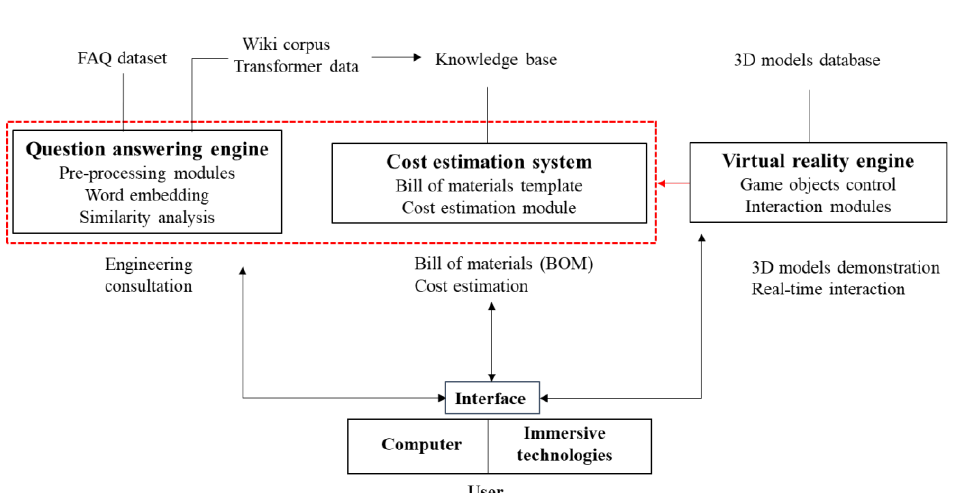
Figure 5. The framework of the NLP-enabled VR-based engineering consultation Chatbot system.